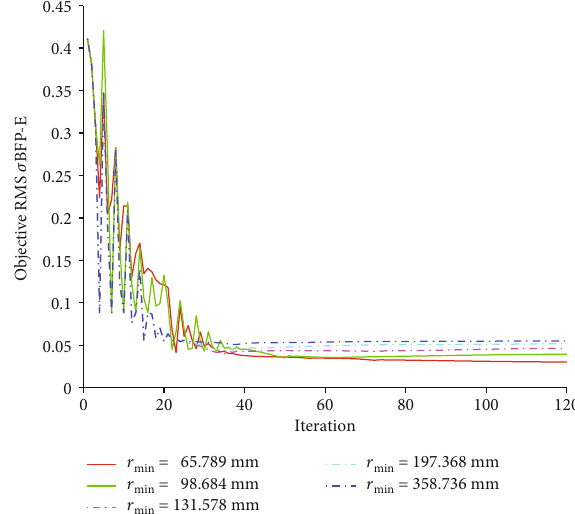
Figure 6: Iteration curves of re fl ector thickness optimization based on di ff erent fi lter